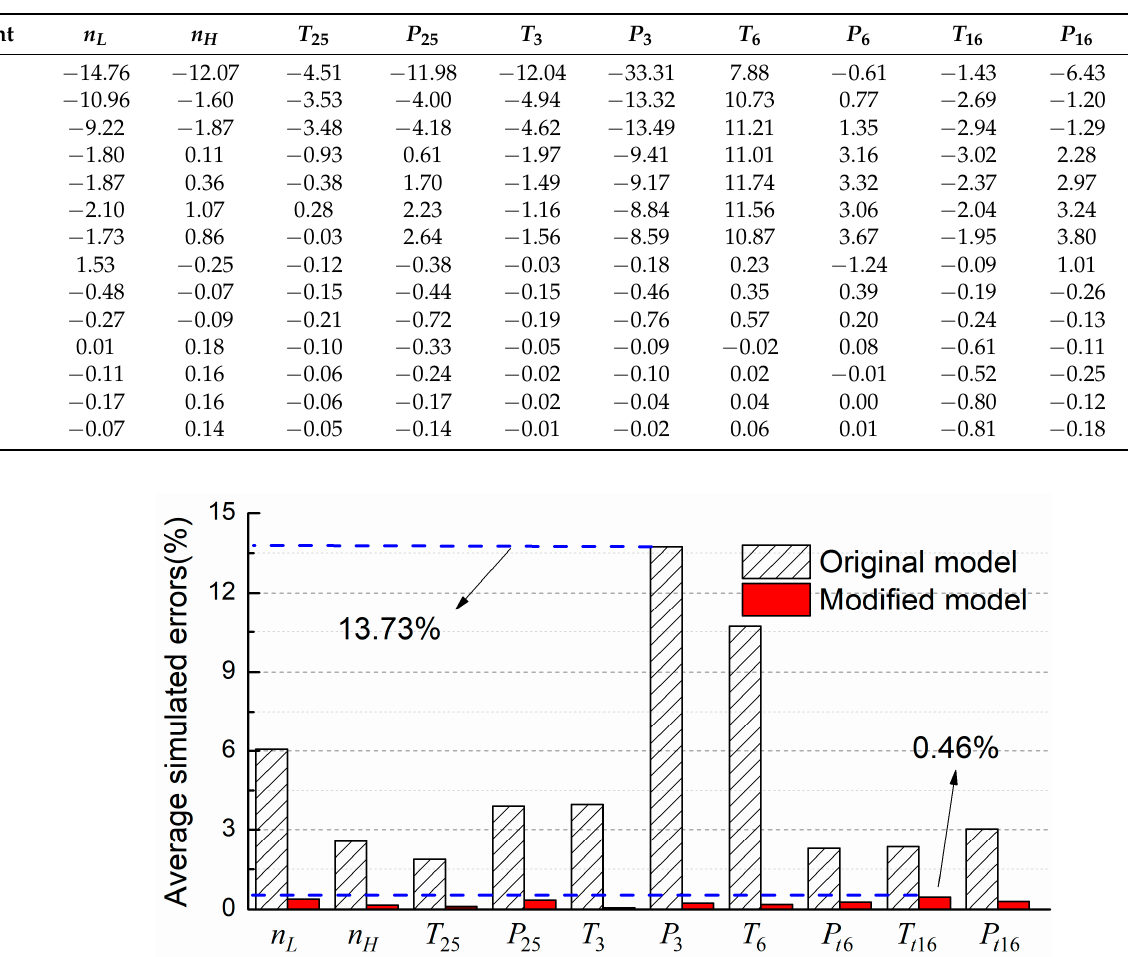
Table 5. Simulated errors compared with experimental data before and after model adaptation (%).